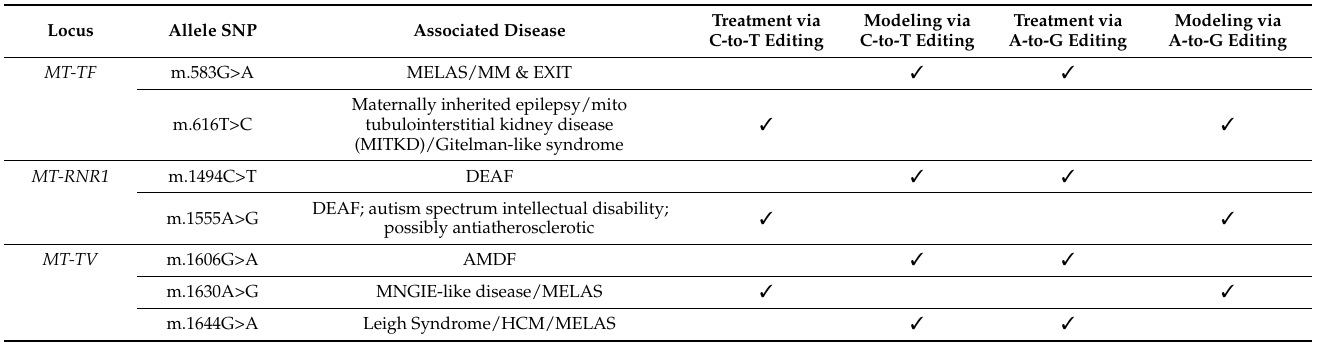
Table 1. Pathogenic mitochondrial mutations confirmed with MITOMAP [13]. Out of 91 confirmed pathogenic point mutations, 86 can potentially be corrected or modeled using the DdCBE and TALED mtDNA base editing platforms. Figure 2 contains further